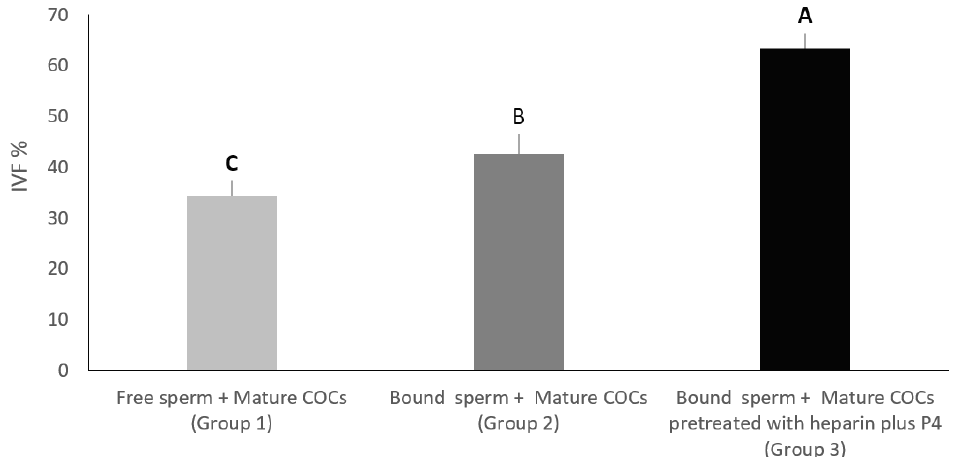
Figure 5. In group 1, mature COCs without any treatments were added to free sperm cells. In group 2, mature COCs pre-treated with heparin 40 μ g/mL plus progesterone at 80 nanomolar, as well as free sperm. In group 3, sperm cells were incubated with cell aggregates from the isthmus plus mature COCs pre-treated with heparin 40 μ g/mL plus progesterone at 80 nanomolar. All groups were incubated for fertilization. Columns with different letters are significantly different p < 0.05.